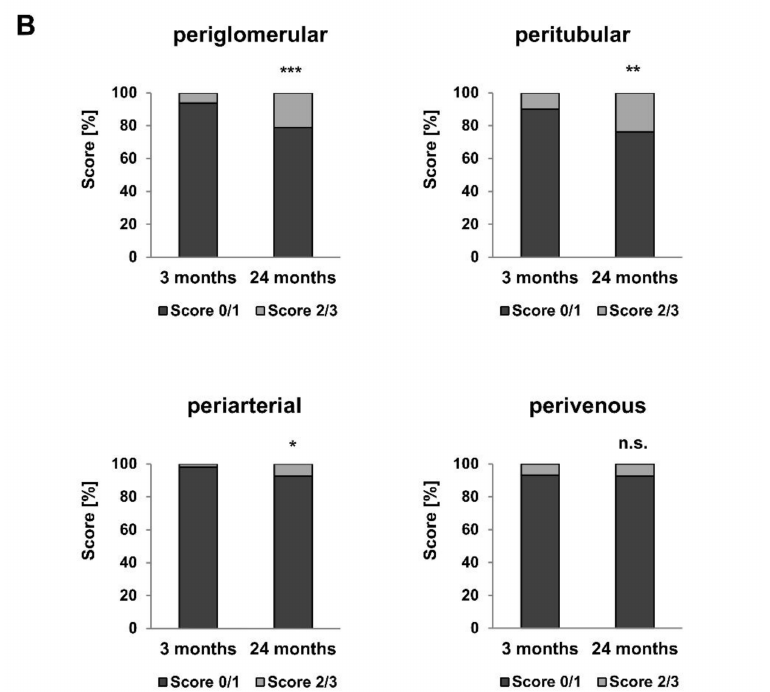
Figure 6. Glomerular and interstitial infiltration of T cells in 3- and 24-month-old rats. ( A ) Immuno- histochemistry with CD3 antibody (magnification × 200). Intraglomerular infiltration of CD3-positive T cells was significantly reduced in 24-month-old rats ( B ). In contrast periglomerular, peritubular, and periarterial infiltration of T cells was significantly increased in 24-month-old rats. Perivenous T cell infiltration was also increased in old rats, albeit not significantly. For all Figures p -values ≤ 0.05, ≤ 0.01, and ≤ 0.001 are indicated by one, two or three asterisks, respectively.